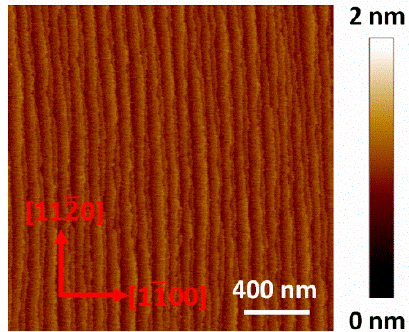
Figure 2. AFM height images (2 × 2 µ m 2 ) on the unpatterned area of sample A. Figure 2. AFM height images (2 × 2 μ m 2 ) on the unpatterned area of sample A. Figure 2. AFM height images (2 × 2 μ m 2 ) on the unpatterned area of sample A. Figure 2. AFM height images (2 × 2 μ m 2 ) on the unpatterned area of sample A.